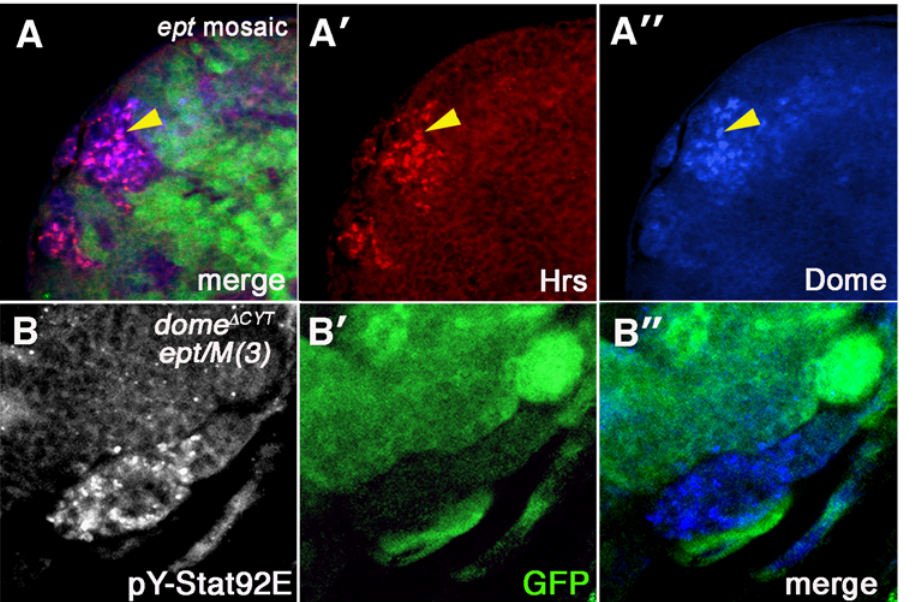
Figure 6. Dome localization in ept mutant tissue. (A-A 0 ) A clone of ept 2 mutant eye disc cells marked by the absence of GFP (green) stained for Dome (blue) and the endocytic marker Hrs (red) shows extensive accumulation of Dome in Hrs-positive structures (yellow arrowhead denotes example of magenta overlap). (B-B 0 ) A confocal image of a section of an ept 2 eye-antennal tumor expressing dome D CYT (using the eyFLP;Actin . CD2 . Gal4, UAS- GFP system) and stained for anti-pYStat92E (blue); GFP (green) marks cells that express the dome D CYT transgene. The anti-pY-Stat92E epitope is strongly reduced in cells that express dome D CYT but not in the patch of GFP-negative, ept 2 mutant cells that do not express dome D CYT .